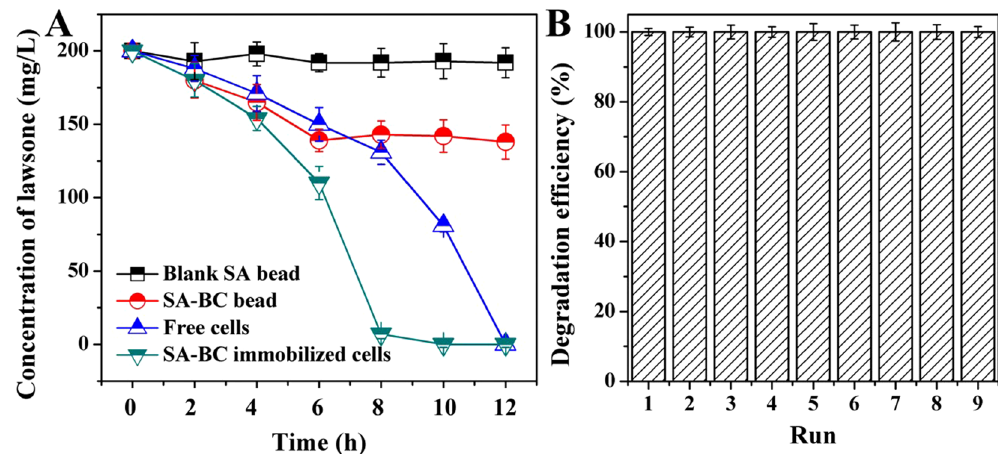
Figure 6. ( A ) Variation of the concentration of lawsone in the presence of blank alginate bead ( ■ ), alginate- biochar bead ( ), free LH-3 cells ( ), and alginate-biochar immobilized cells ( ); ( B ) Degradation efficiencies of alginate-biochar immobilized LH-3 cells towards lawsone in 9 successive runs. (The experimental conditions were given in the Section 2.3 and were 200 mg L − 1 lawsone, 30 °C, pH of 7.0 unless otherwise stated. The inoculation quantities of free and immobilized cells were both 2% (v/v). The duration of each run in B was 12